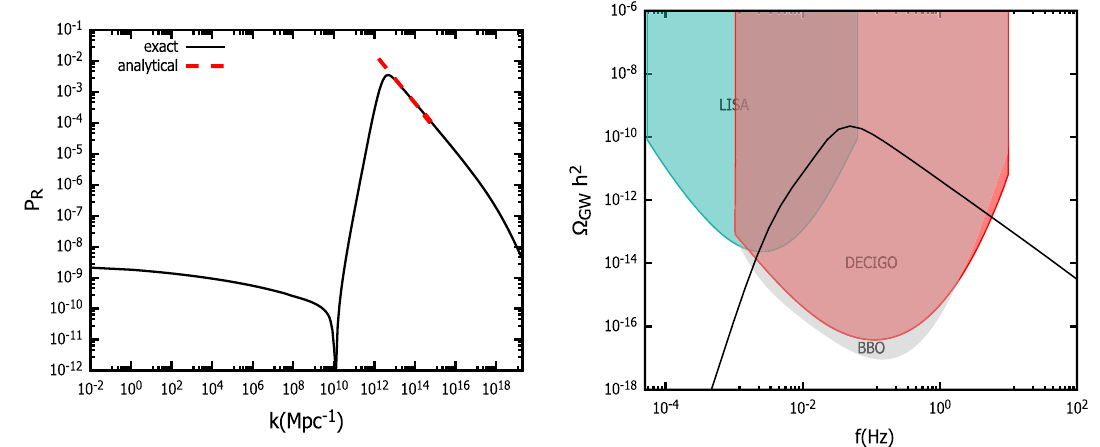
Fig. 6 The power spectrum (left) with solid line (numerical) and with dashed (analytical from Eq. 2.34). The density of stochastic GWs (right) for the case of modifying Cecotti. The parameters are d = − 0 . 054, b 4 = 7 . 51511, c 4 = 8 . 8, ¯ λ = − 0 . 5 and ¯ μ = 1 .